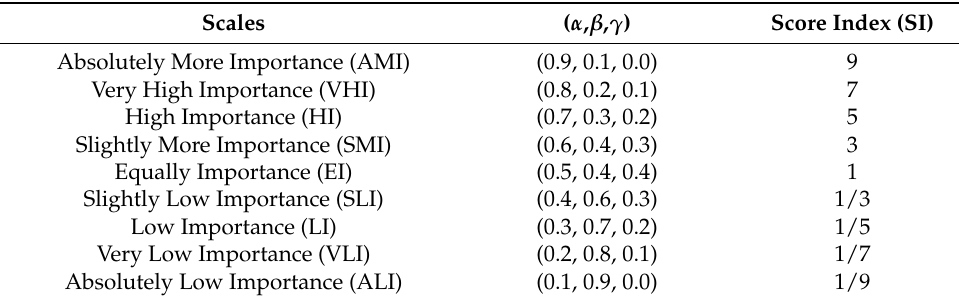
Table 3. SF-AHP linguistic terms.